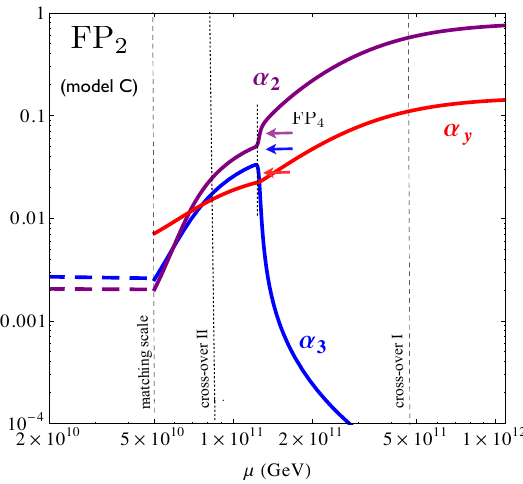
Figure 11 . High-scale matching of a partially interacting (cid:12)xed point FP 2 onto the SM for the benchmark scenario C with ( R 3 ; R 2 ; N F ) = ( 10 ; 4 ; 80). Trajectories emanate out of the UV (cid:12)xed point FP 2 and initially cross over into the vicinity of FP 4 (indicated by arrows) at around 1 : 5 (cid:2) 10 11 GeV. Subsequently, trajectories display a second cross over to match with the SM at about M = 5 (cid:2) 10 10